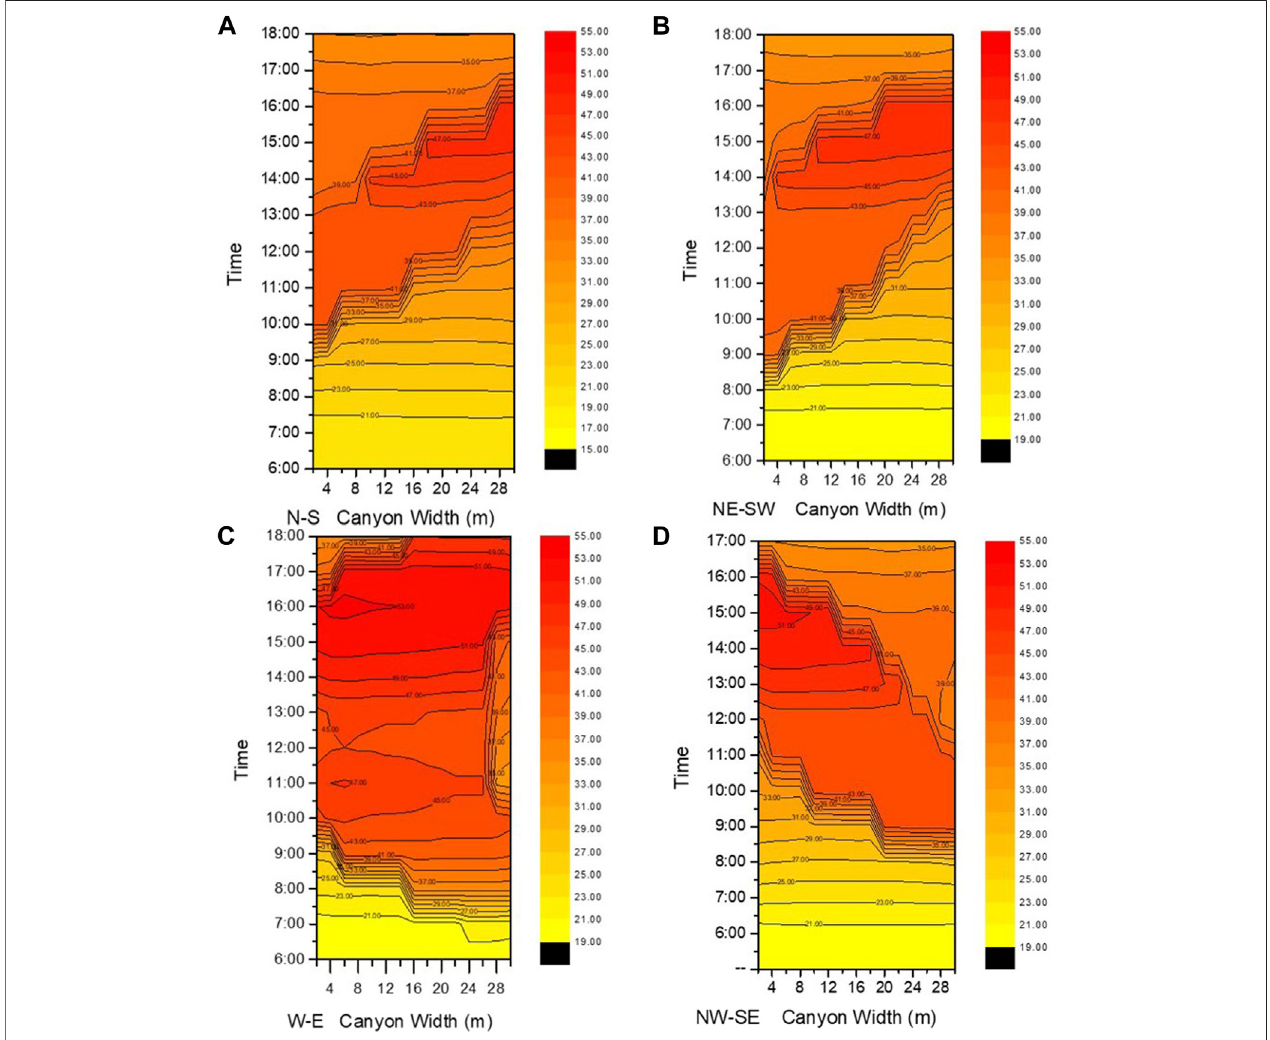
FIGURE 9 | Temporal and spacial variations in PET at the pedestrian level within the street canyons in different orientation-N – S (A) , NE – SW (B) , W – E (C) and NW – SE (D) .